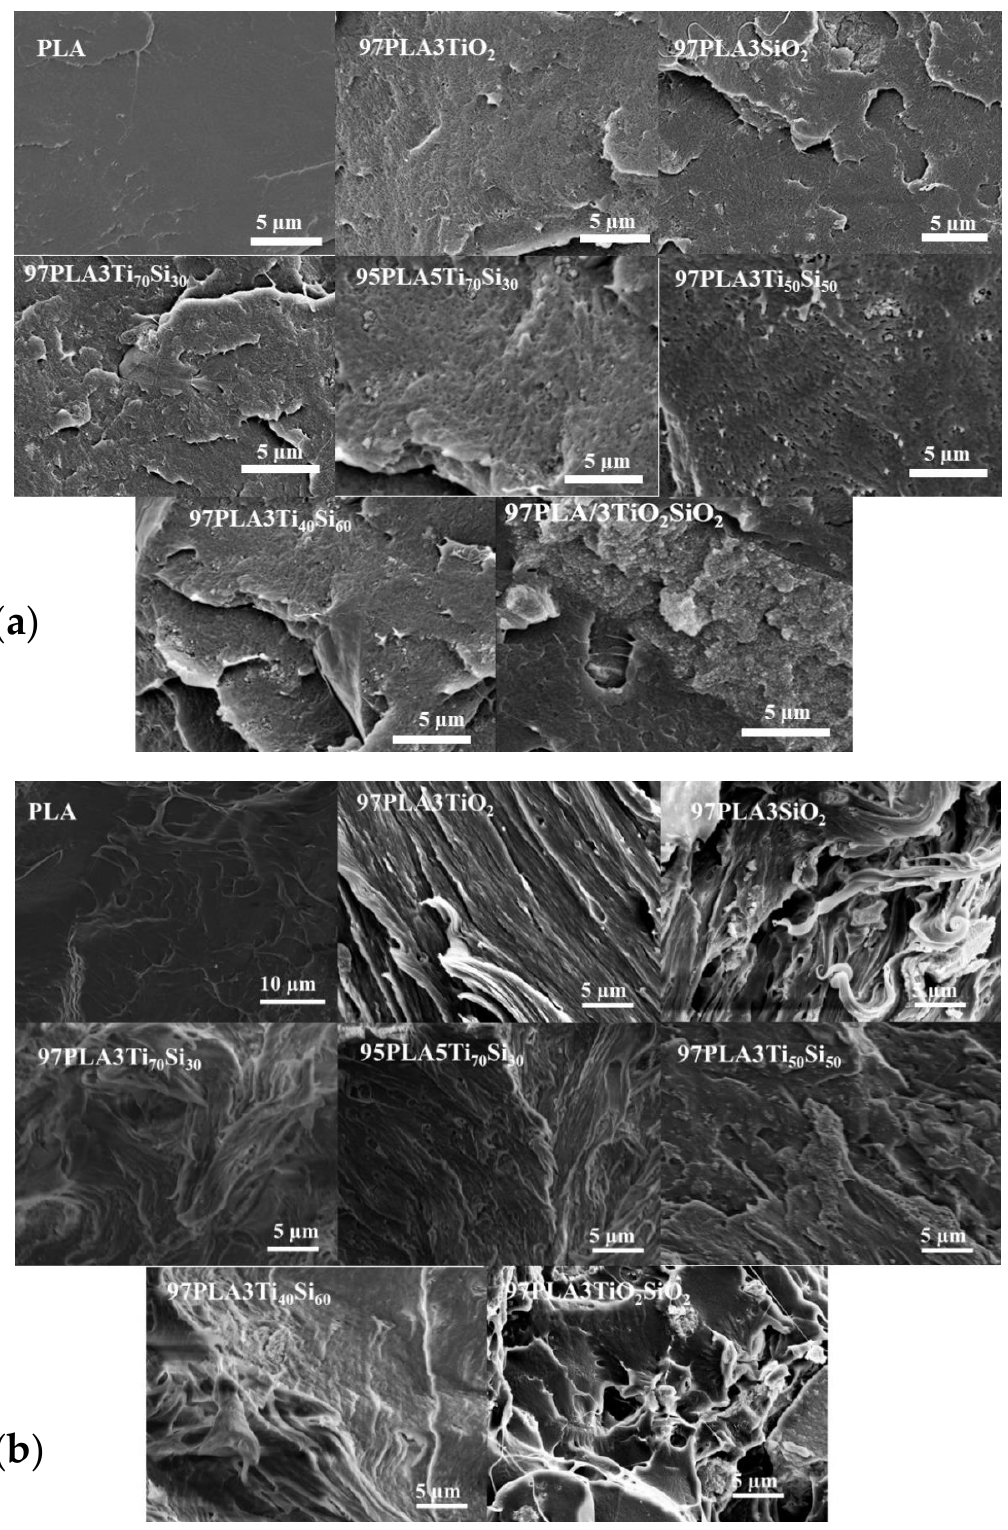
Figure 5. SEM micrographs (×2.5 k, WD = 13 – 15 mm, acceleration voltage 9 – 12 kV) of ( a ) the fracture surface and ( b ) after tensile testing of PLA, PLA/TiO 2 , PLA/SiO 2 , PLA/Ti x Si y , and PLA/TiO 2 SiO 2 composites.